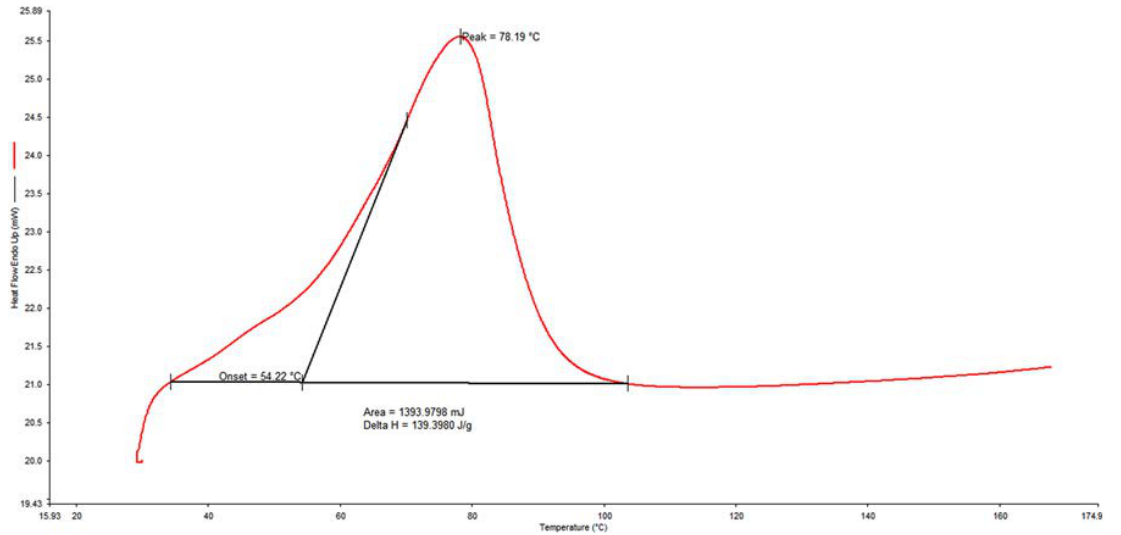
Figure 5. DSC plot of the surface-modified Bi 2 O 3 NPs using β -CD functionalized with biotin.